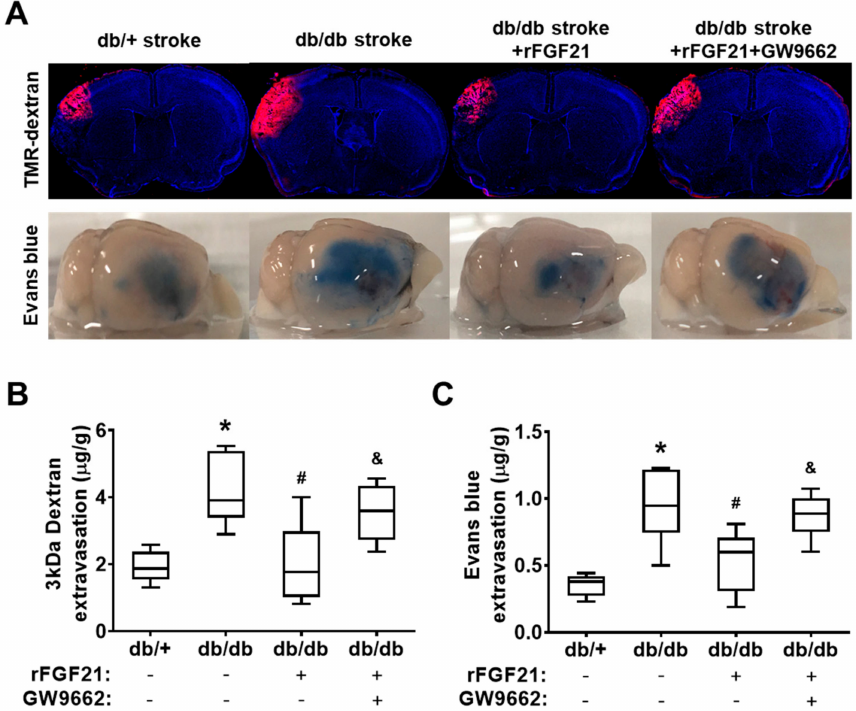
Figure 2. rFGF21 reduces blood–brain barrier (BBB) extravasation via PPAR γ activation at a peri-infarct area after dMCAO in db / db mice. At 48 h poststroke, extravasations of 3 kDa TMR-dextran and Evans blue dye were measured by a spectrometer. ( A ) Representative images of 3 kDa TMR-dextran and Evans blue extravasations. ( B ) Quantification of 3 kDa TMR-dextran extravasation. ( C ) Quantification of Evans blue dye extravasation. Data are illustrated as box-plots with the median, lower and upper quartiles, minimal and maximal value ( n = 6 per group). * p < 0.05 for db / db stroke vs. db /+ stroke; # p < 0.05 for db / db stroke + rFGF21 vs. db / db stroke; & p < 0.05 for db / db stroke + rFGF21 + GW9662 vs. db / db stroke +